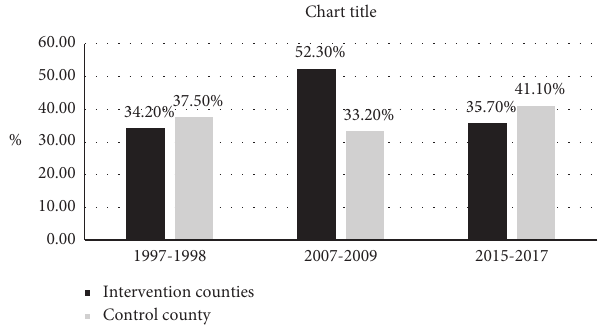
Figure 4: Changes in the proporton of case/NCD death for CVD between 1997 and